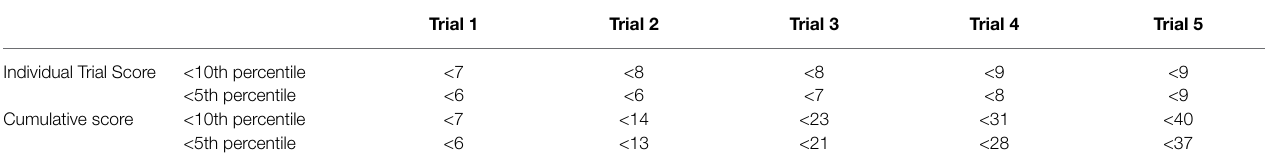
TABLE 4 | Cut-off scores for individual trials, and for cumulative scores across trials, at which performance on the Lhermitte board falls below the 10th and 5th percentiles.